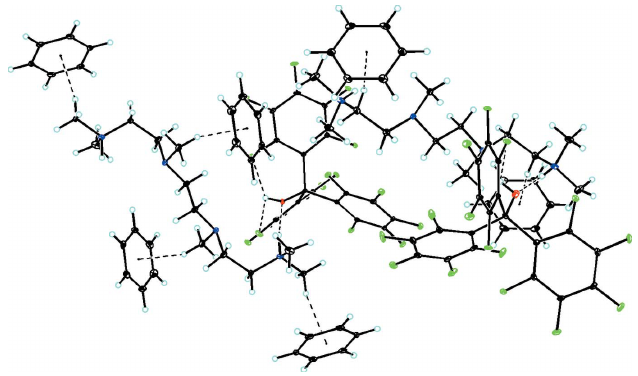
Figure 3 Diagram showing the numerous C—H (cid:2)(cid:2)(cid:2) (cid:2) interactions between the [C 12 H 32 N 4 ] 2+ dications and all the three benzene solvate molecules, also including the [C 18 HBF 15 O] (cid:3) anions.